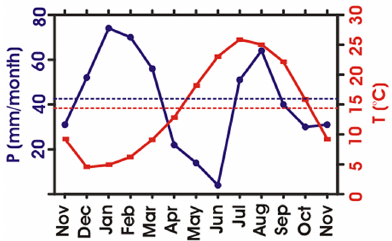
Figure 5. Mean monthly values of precipitation (blue) and air tem- perature (red) from 1990 to 2010 NLDAS time series within the Tonto Creek watershed divide. Dashed lines represent mean annual value for each variable. A water year starting in November will be used henceforth to better visualize the changes in maximum and minimum values due to forest thinning along the